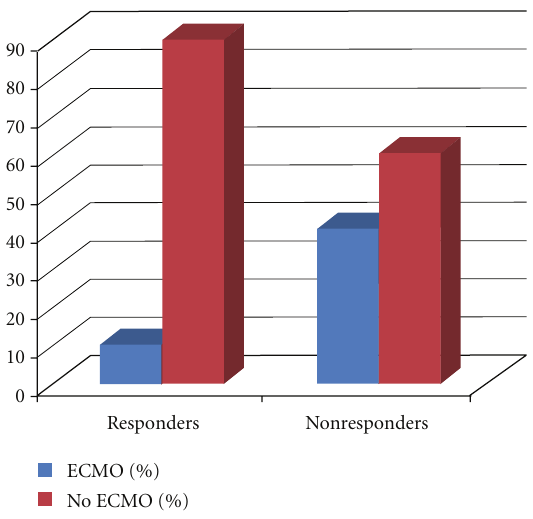
Figure 3: Need for ECMO in responders versus nonresponders.